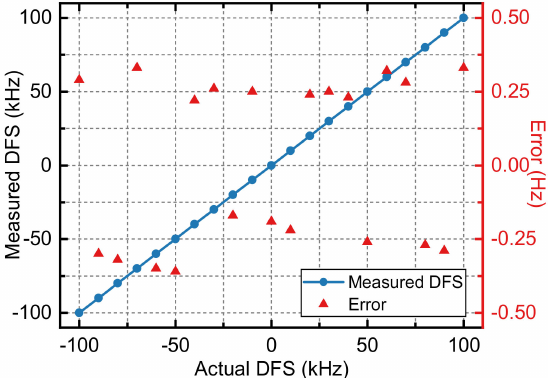
Figure 4. Measured DFS (blue circular line) and corresponding errors (red triangular) for the DFS changed from − 100 kHz to 100 kHz with a step of 10